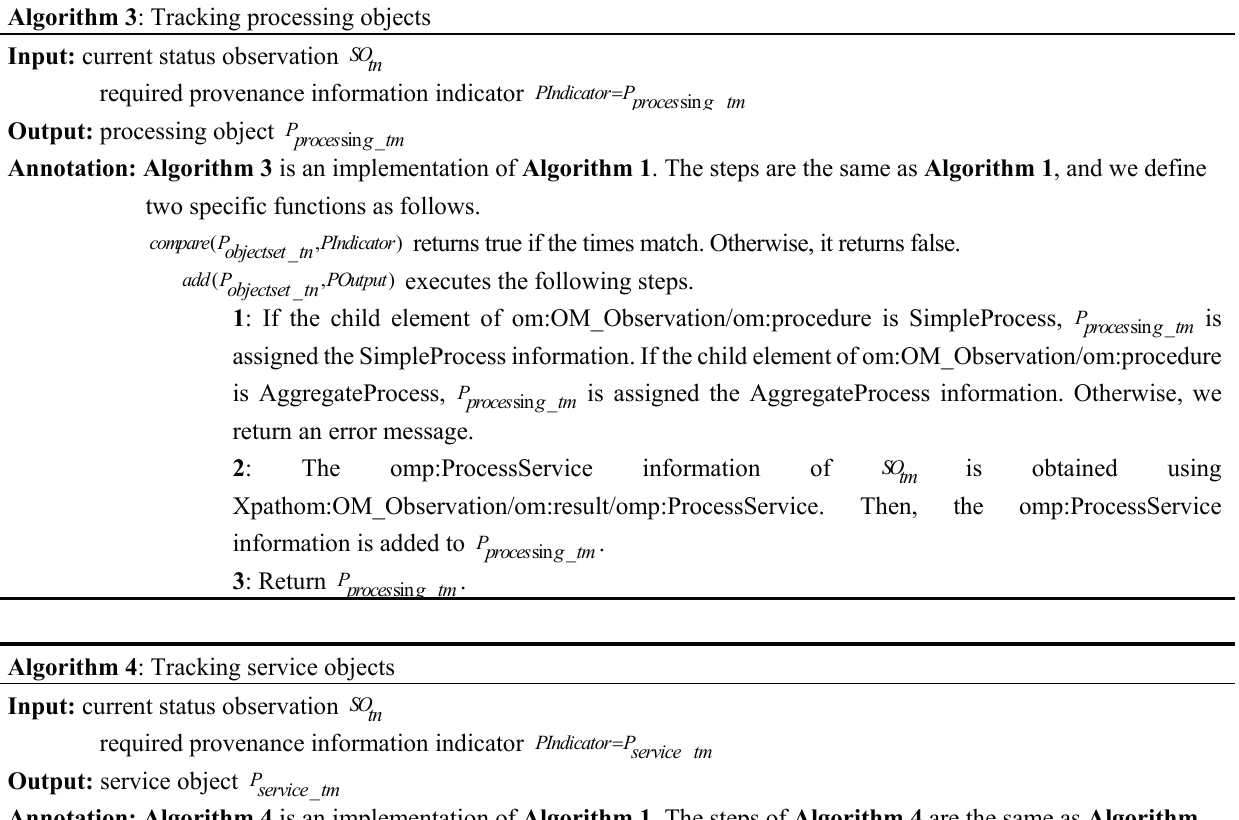
Algorithm 4 : Tracking service objects